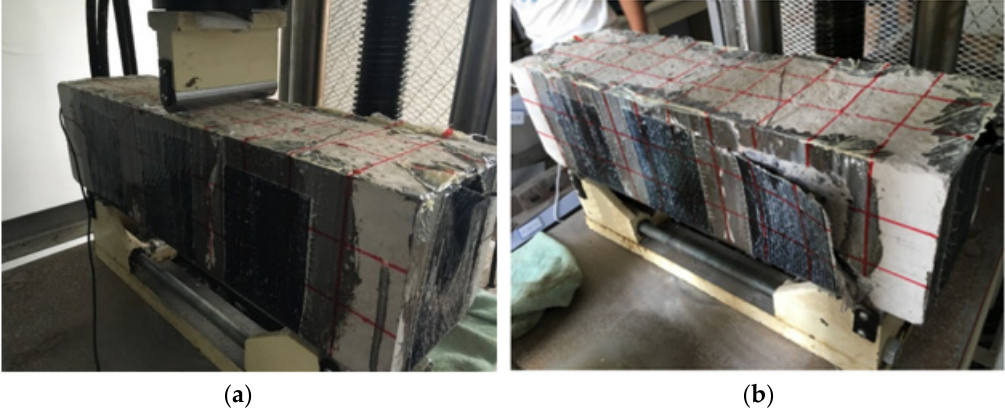
Figure 11. Test procedure ( a ) initial condition ( b ) collapse at load of 76.6 kN.